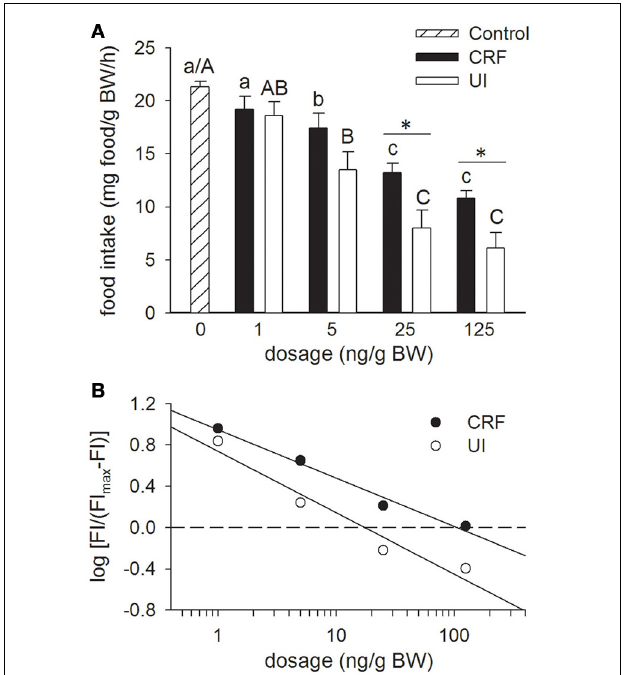
FIGURE 1 | Effects of teleost Ringer’s (0.2% NaHCO 3 in 0.6% NaCl; Control treatment), rainbow trout CRF (rtCRF) or rtUI i.c.v. injections on food intake in rainbow trout. (A) Fish received food 10min after i.c.v. injection and food intake was assessed over a 120min period. Control and